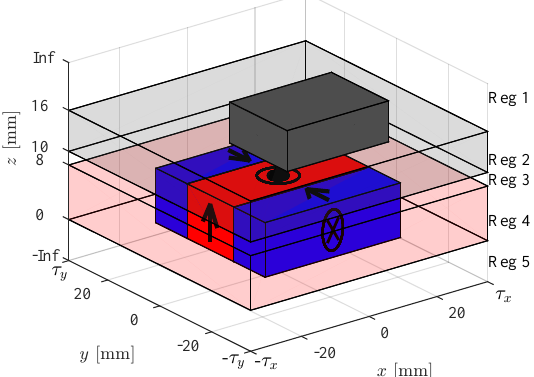
Figure 2. Electromagnetic configuration consisting of three magnets with a slab of magnetic material above